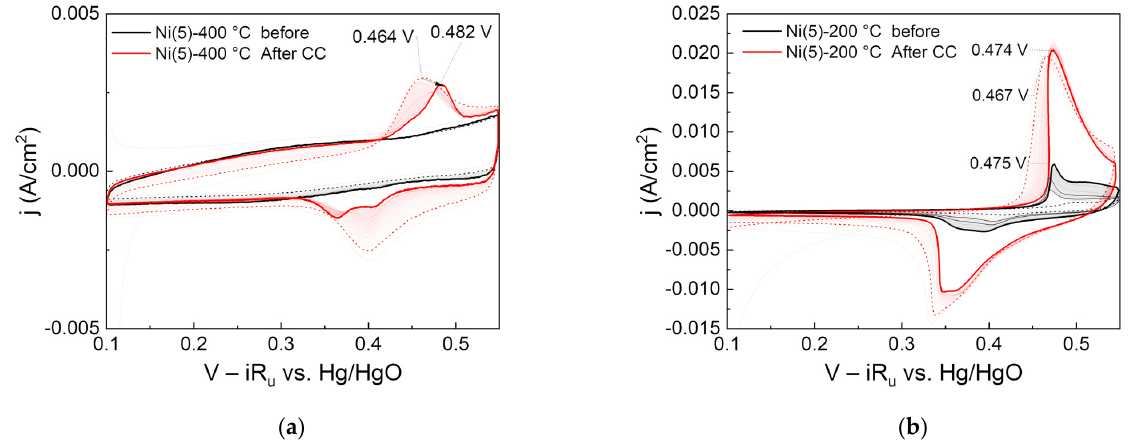
Figure 7. Cyclic voltammograms of ( a ) Ni(5)-400 °C and ( b ) Ni(5)-200 ℃ : 150 CV cycles each were performed before (indicated as black line) and after (indicated as red line) 2 h CC (100 mA/cm 2 ) operation. Dotted and emboldened lines are for the 2nd and last CV cycle, respectively.